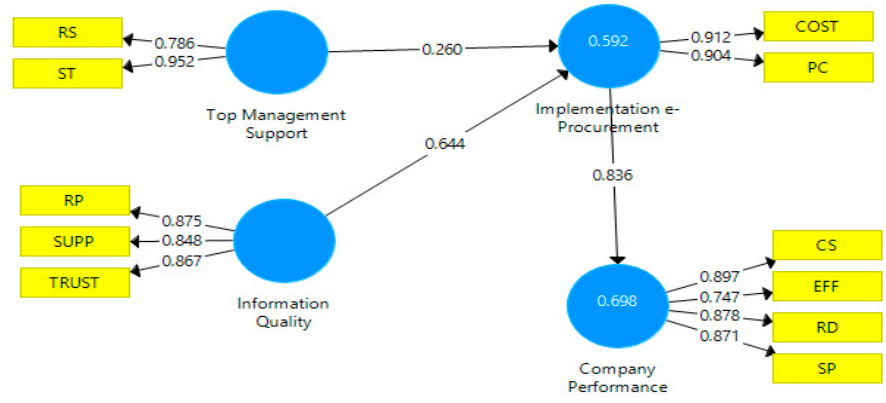
Figure 2. Path diagram.